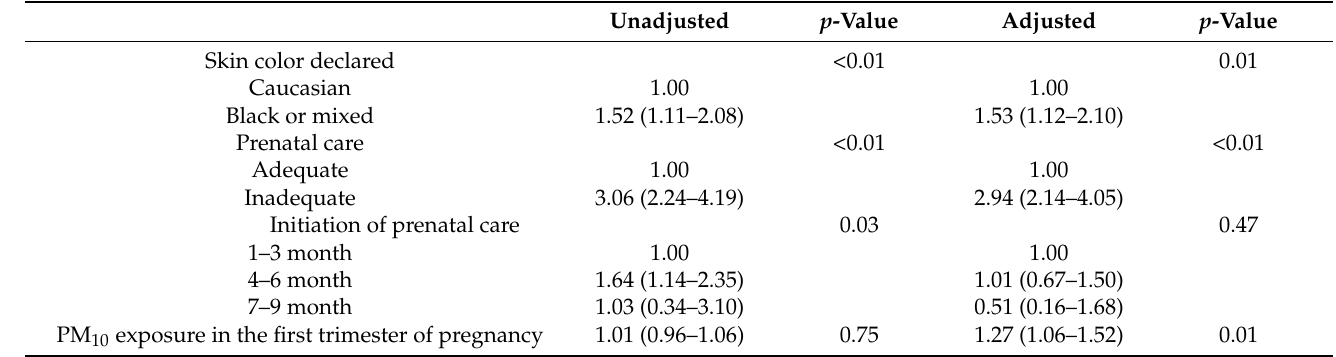
Table 6. Unadjusted and adjusted prevalence ratios (with 95% confidence limits) for low birth weight among a coal mining area in